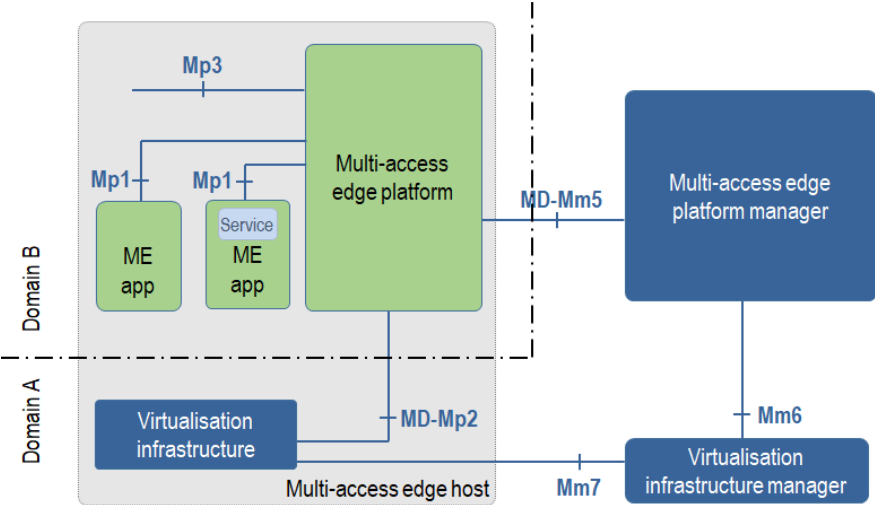
Figure 3. Integration of MEC providers at platform level following a Platform-as-a-Service (PaaS) approach with infrastructure owned by Domain A provider.